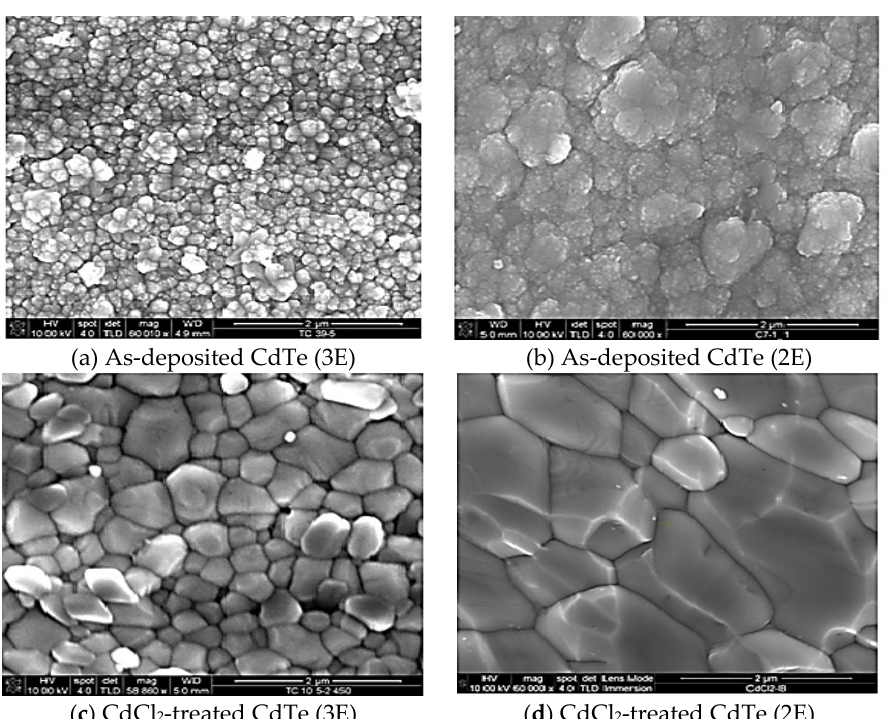
Figure 3. Typical SEM images for as ‐ deposited and CdCl 2 ‐ treated CdTe layers grown by the 3E system ( a , c ) and the 2E system ( b , d ). CdCl 2 treatment was carried out in a conventional furnace at 450 °C for 20 min in air, in the presence of CdCl 2 .